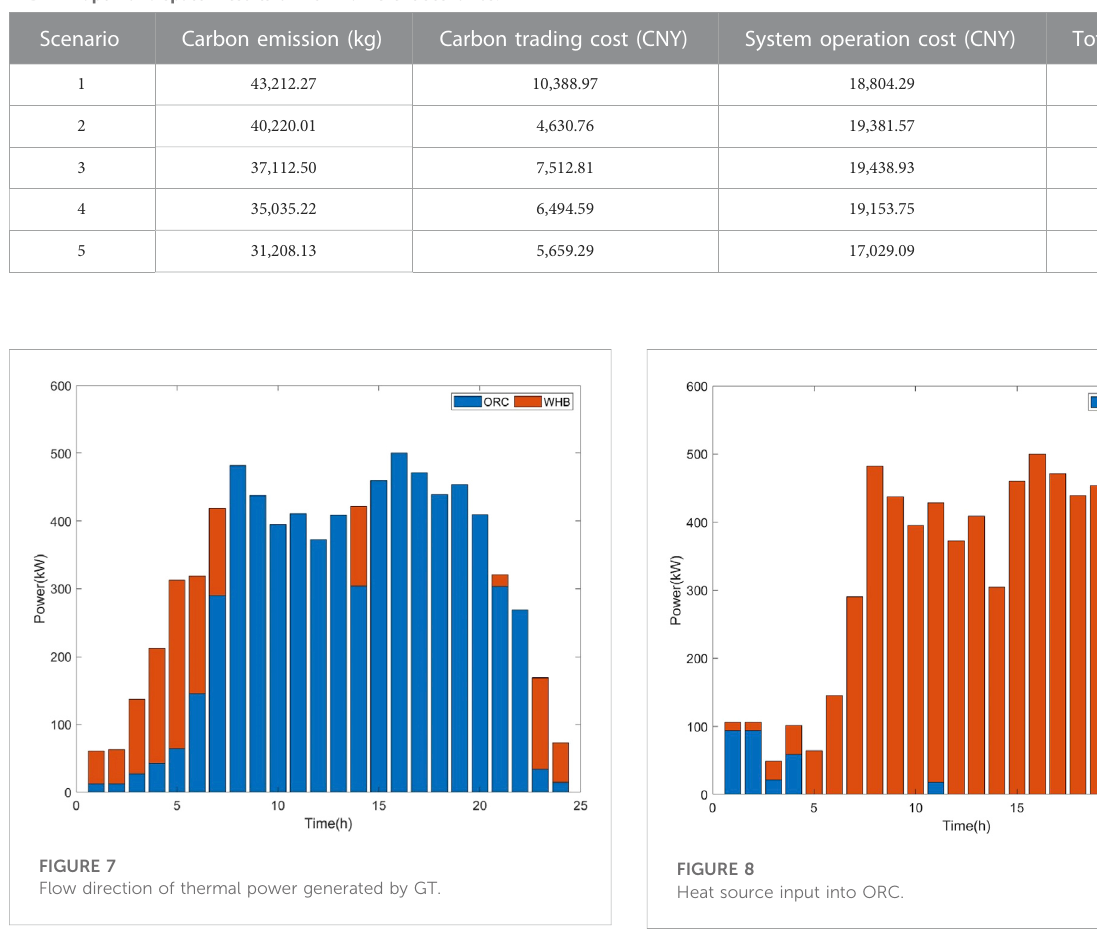
TABLE 4 Optimal dispatch results of IES in different scenarios.